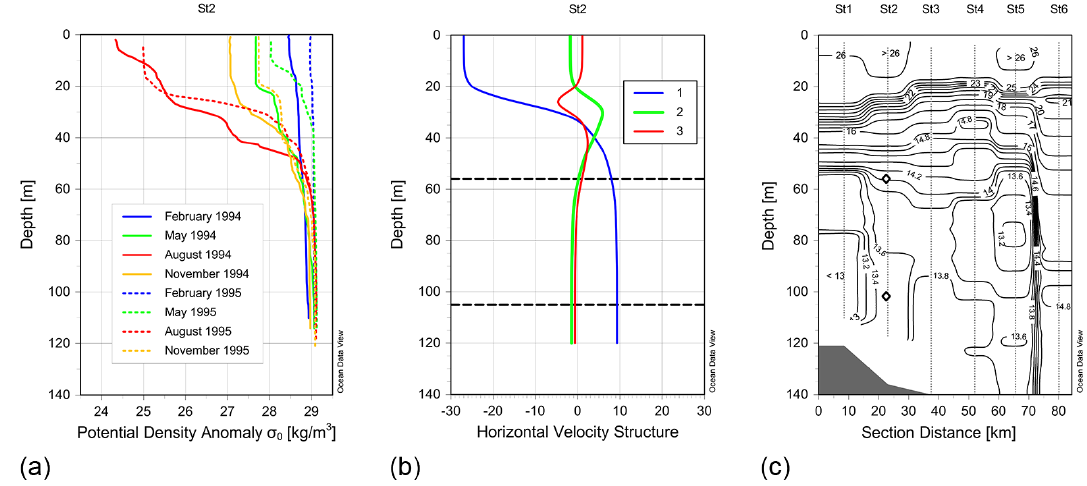
Fig. 10. (a) Potential density anomaly from the CTD surveys conducted in close proximity of St2 during OTRANTO/OGEX projects. (b) Vertical distribution of the first three horizontal velocity modes at station St2 calculated from the August 1995 CTD profile. Current- meter depths at St2 during the PR2 time period are indicated by horizontal dashed lines. (c) Vertical distribution of the potential temperature in the upper layer of the Otranto section on 27 August